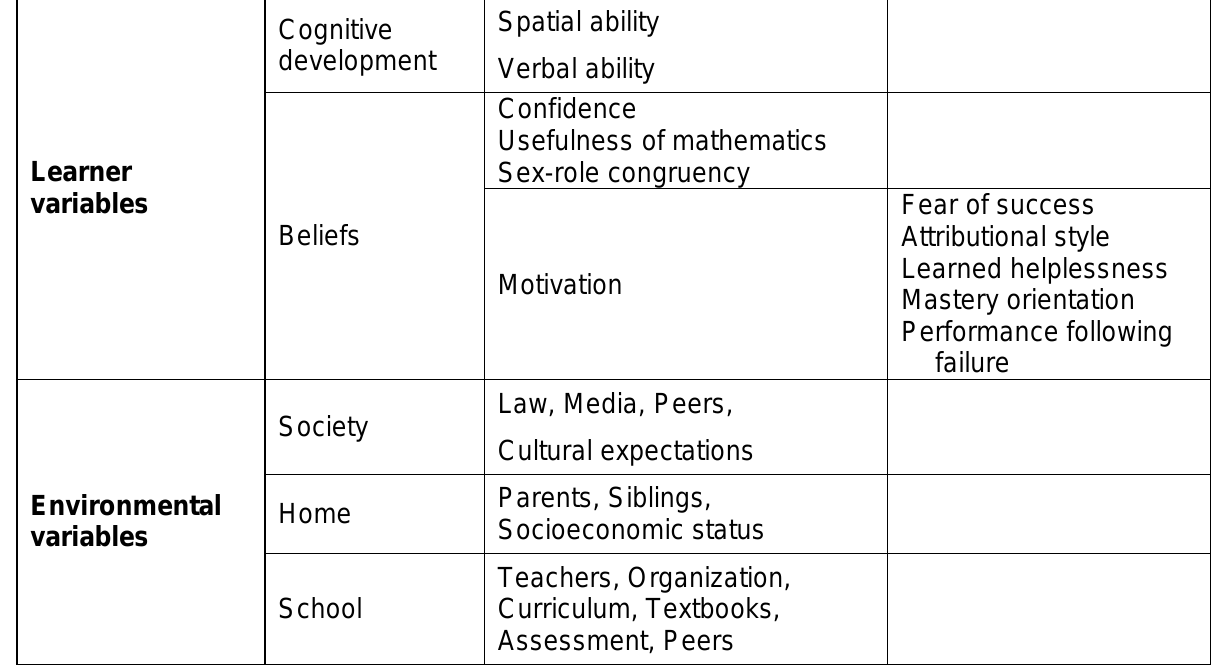
Two categories of variables commonly used to explain gender differences in mathematics learning (adapted from Leder, 1990: